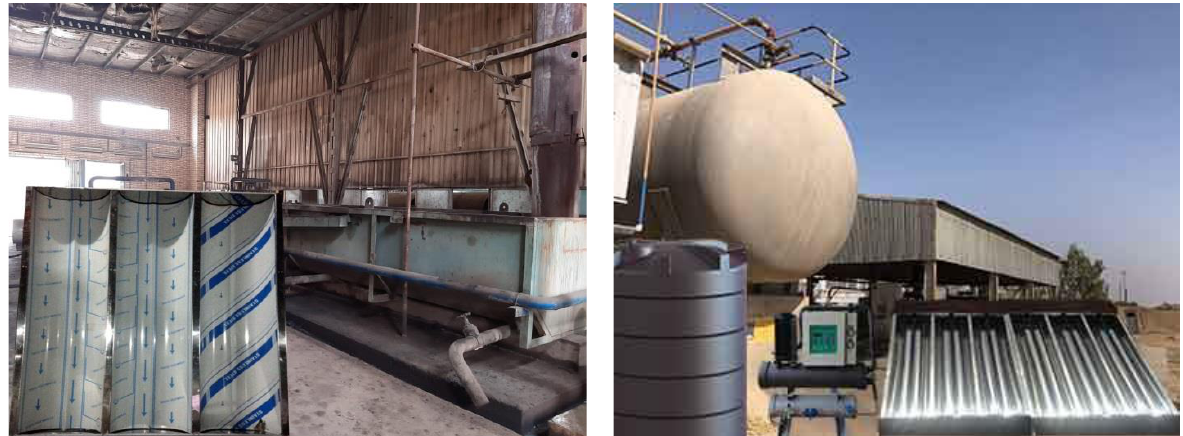
Figure 8. CPC collector system with high-temperature heat pump.